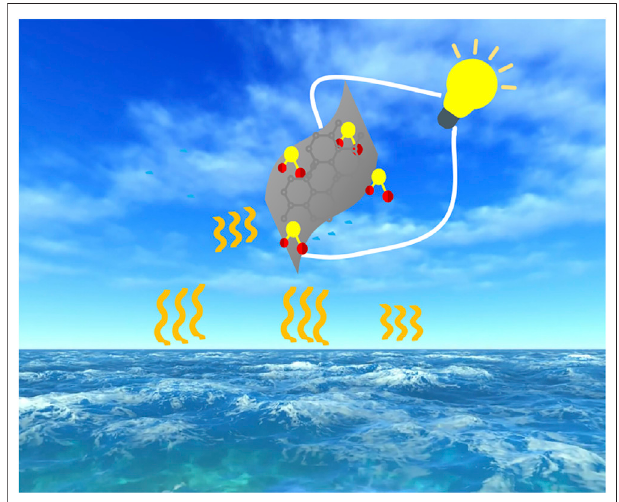
FIGURE 1 | Schematic diagram of